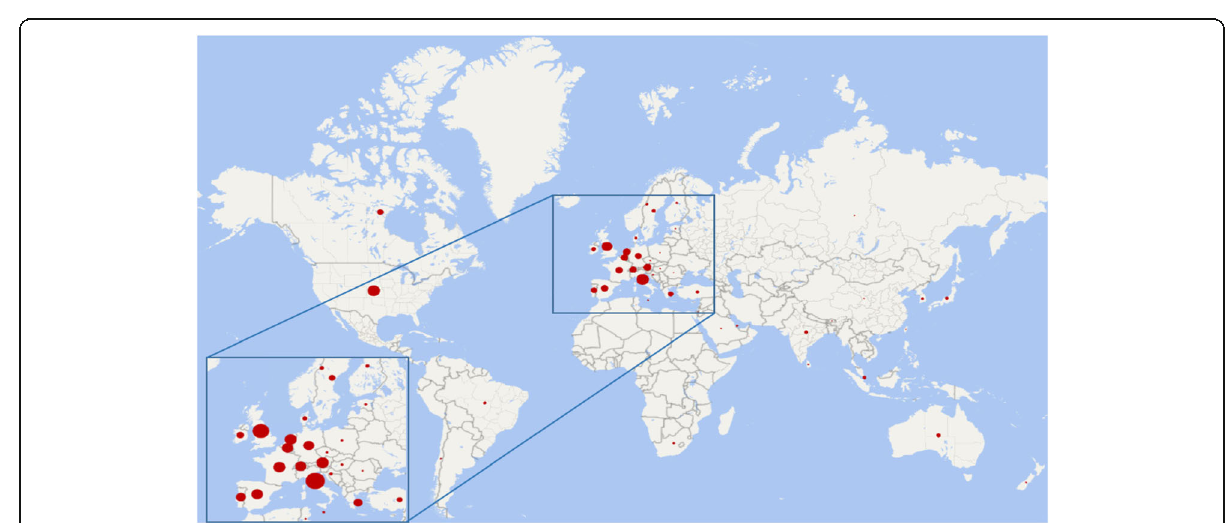
Fig. 2 World map of countries ’